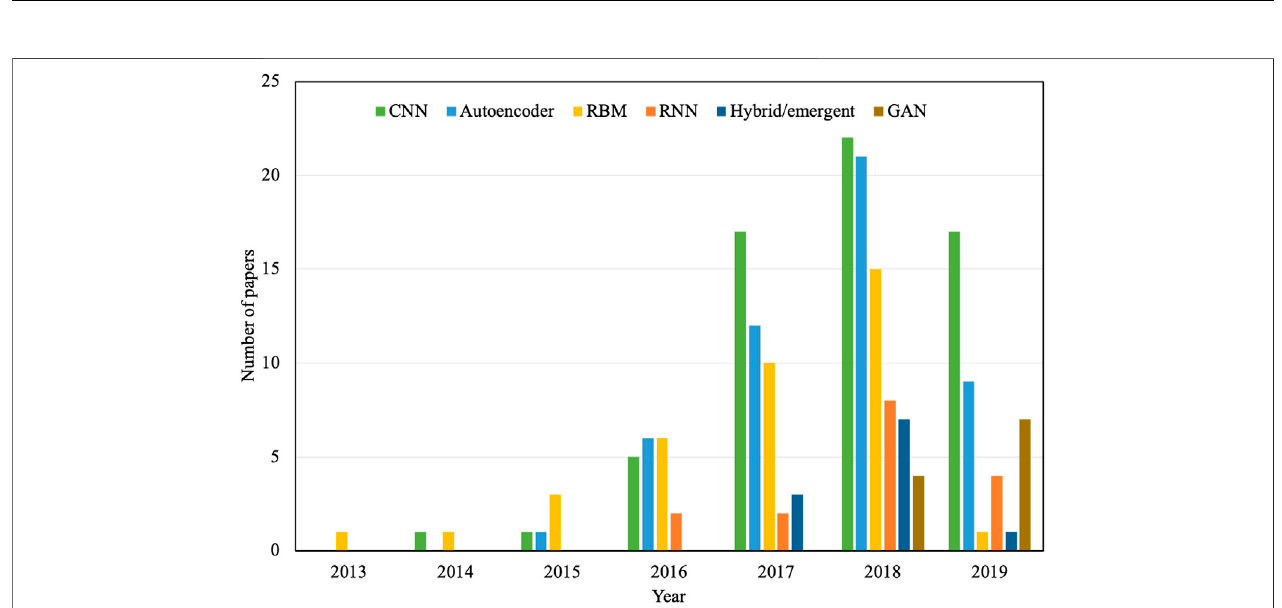
FIGURE 3 | Breakdown of published papers on DL in PHM between 2013 and September 2019 (modi fi ed from Rezaeianjouybari and Shang (2020)) N ote for Figure 3 : DL architecture – share of total publications as follows: CNN (convolutional neural network) — 32.1%; autoencoder — 26.8%; RBM (restricted Boltzmann machine) — 19.6%; RNN (recurrent neural network) — 9.2%; hybrid/emergent — 6.7%; GAN (generative adversarial network) —